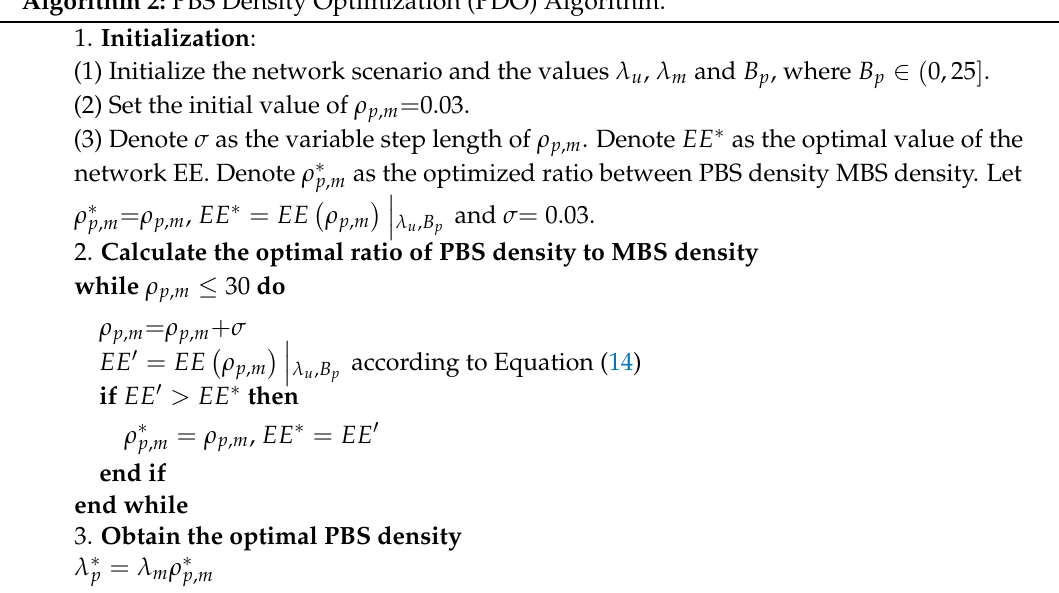
Algorithm 2: PBS Density Optimization (PDO) Algorithm.